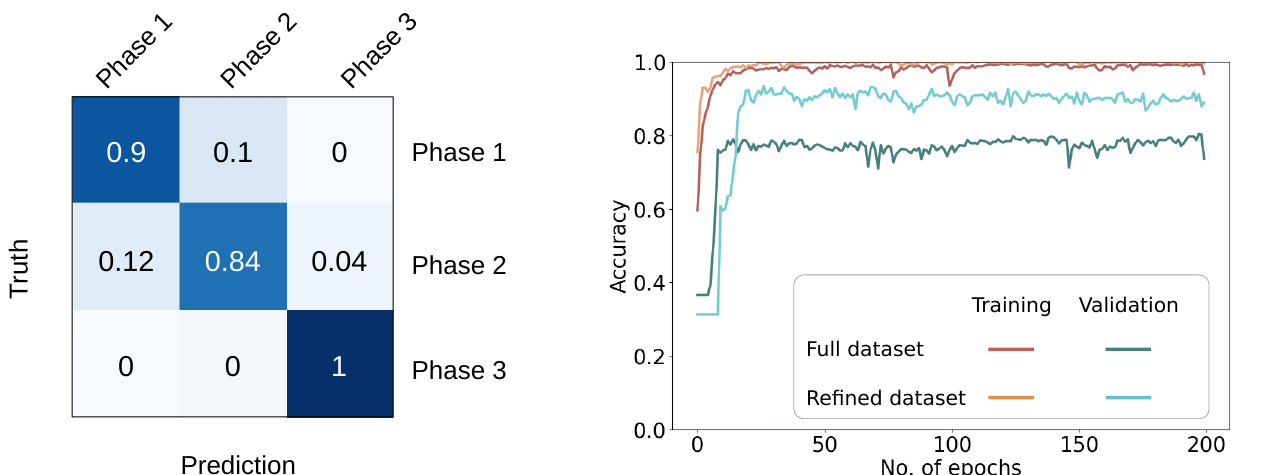
Figure 8. Left : Confusion matrix visualizing the performance of the classifier using the refined dataset. The matrix shows the percentage of correct and incorrect classification of the damage Phase (three phases of damage (Phase 1: Elastic deformation and microcrack initiation, Phase 2: pre-peak microcracking and Phase 3: Microcrack coalescence and post-peak crack localization)). Right : Overall training and validation accuracy of the classifier for 200 epochs.